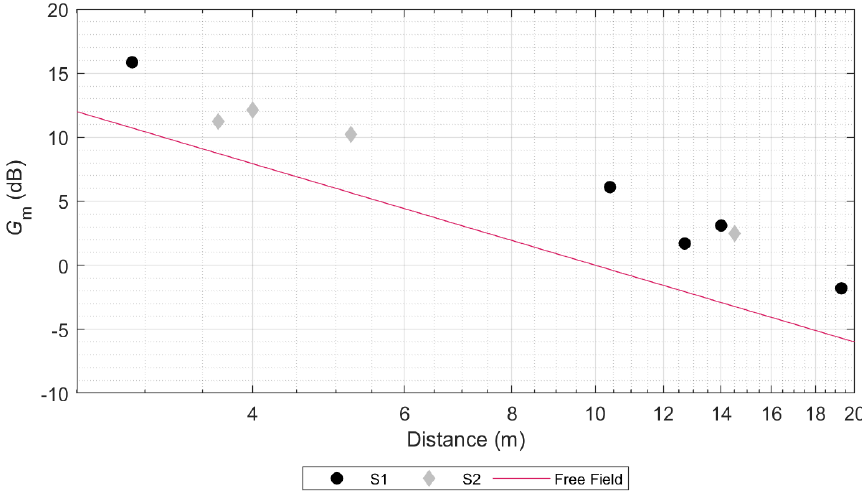
Figure 8. Sound strength, G m (dB), spectrally averaged values calculated from the measured IR in the Bacinete main shelter. The theoretical free field propagation is represented by the red line.